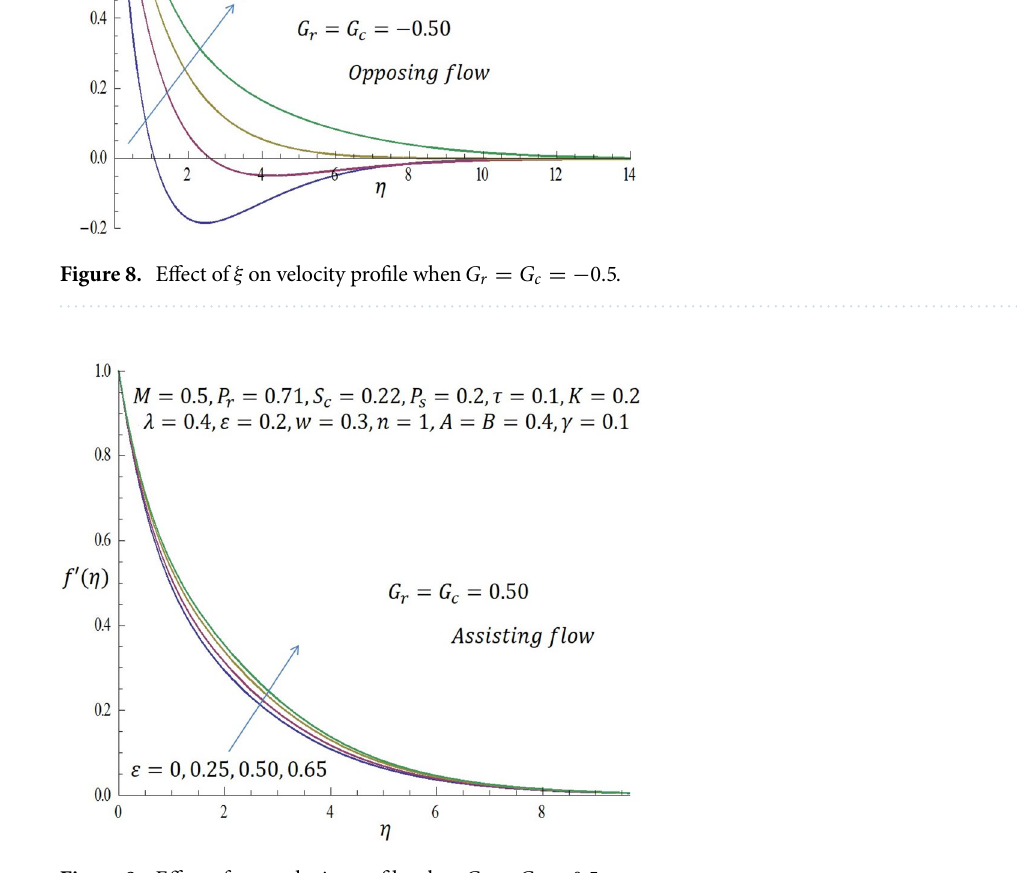
Figure 9. Effect of ε on velocity profile when G r = G c = 0.5